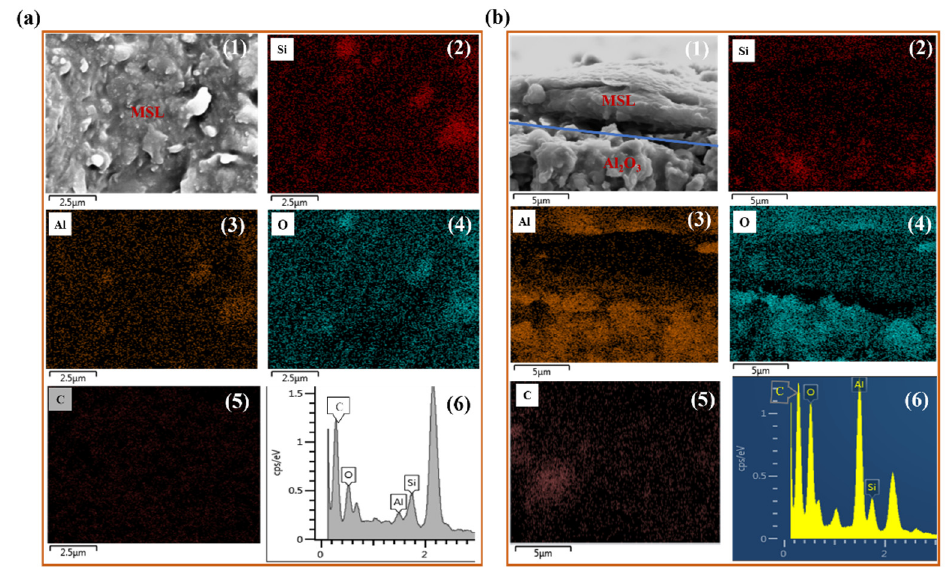
Figure 5. SEM surface ( a 1) and cross ‐ section images ( b 1) of MSL ‐ 10; energy ‐ dispersive X ‐ ray spec ‐ troscopy (EDS) surface ( a ) and cross ‐ section ( b ) imaging of Si (2), Al (3), O (4), and C (5) element troscopy (EDS) surface ( a ) and cross-section ( b ) imaging of Si (2), Al (3), O (4), and C (5) element and and spectra (6) of MSL ‐ 10. spectra (6) of